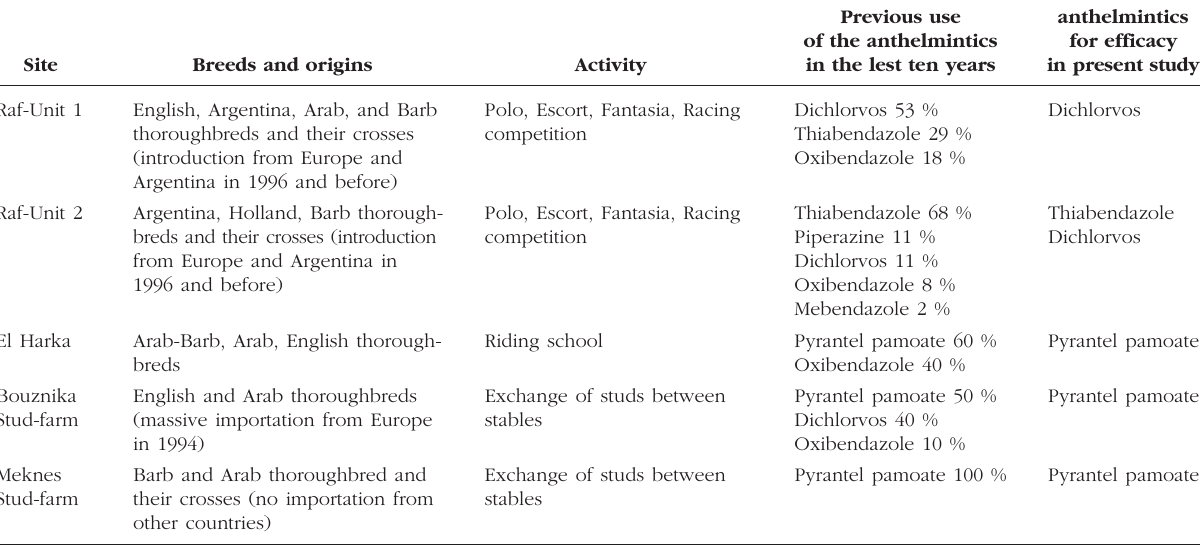
Table I. – Characteristics of horse stables studied in Morocco.